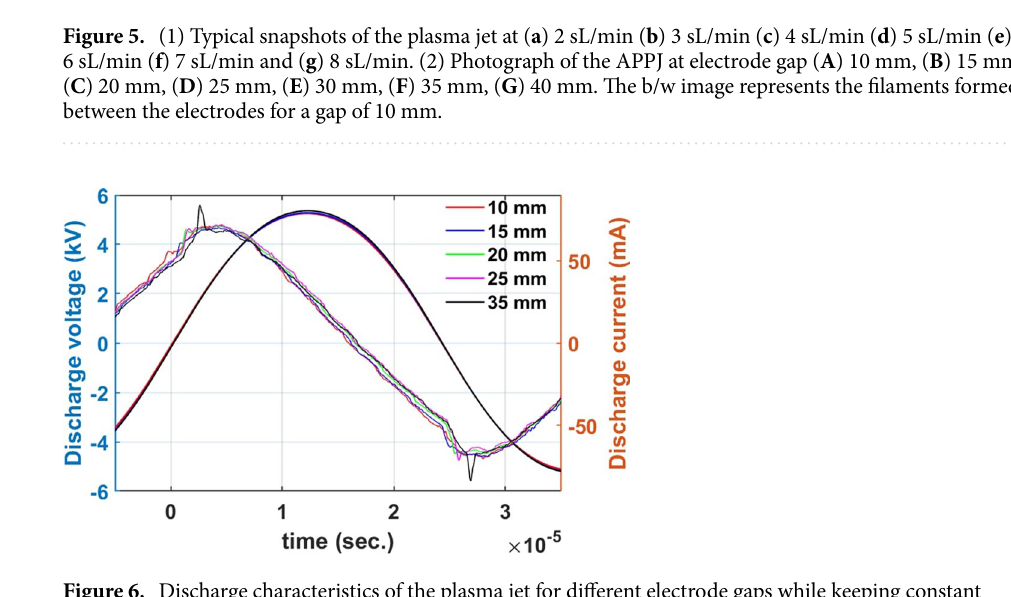
that. However, the width of the plasma jet is continuously increasing with higher Q Ar as shown in Fig. 7d. All other operating parameters are kept constant ( V d = 10.8kV , f = 21kHz and gap = 40 mm). We can understand the change in the plasma jet characteristics from the fluid dynamic calculations. As the flow rate is altered, the fluid regime is determined from the Reynolds number (Re) given by: